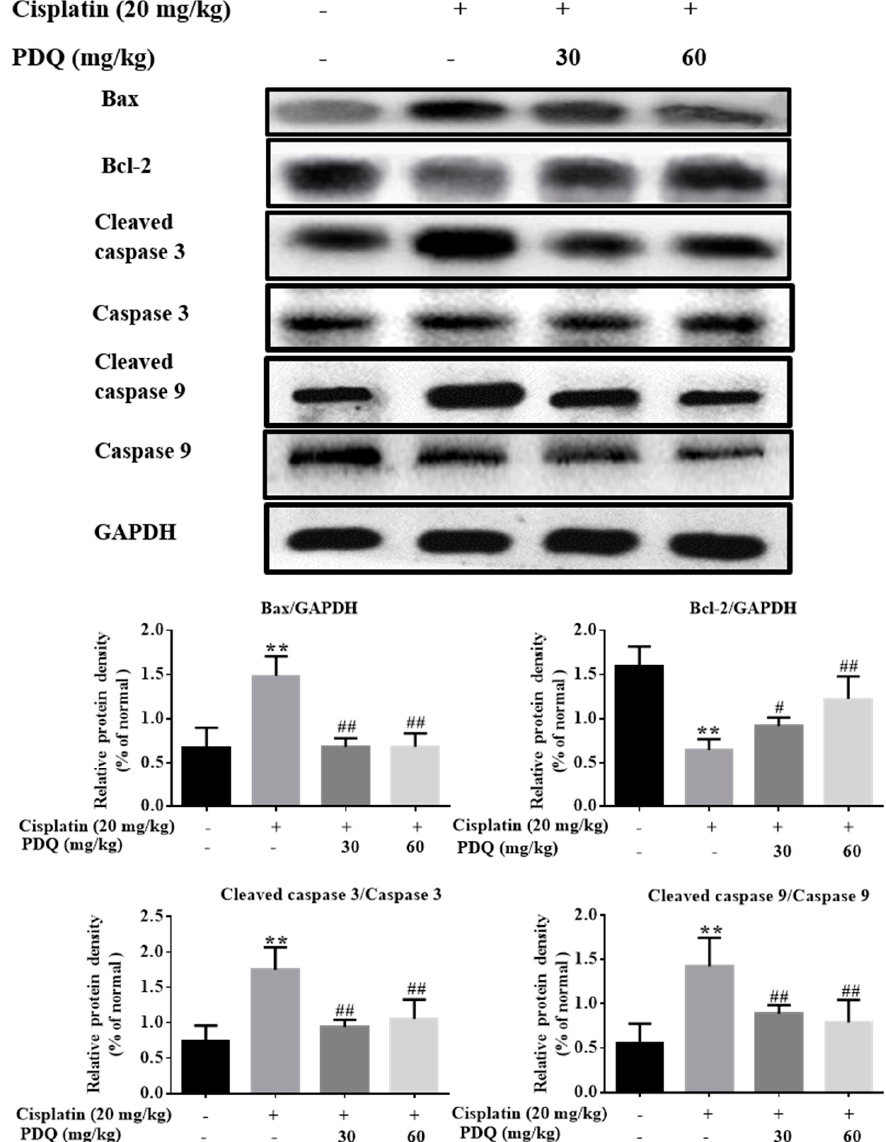
Figure 4. Effects of PDQ on the protein expression of Bax, Bcl-2, caspase-3, and caspase-9. n = 3, ** p < 0.01 vs. normal group; # p < 0.05, ## p < 0.01 vs. cisplatin group.